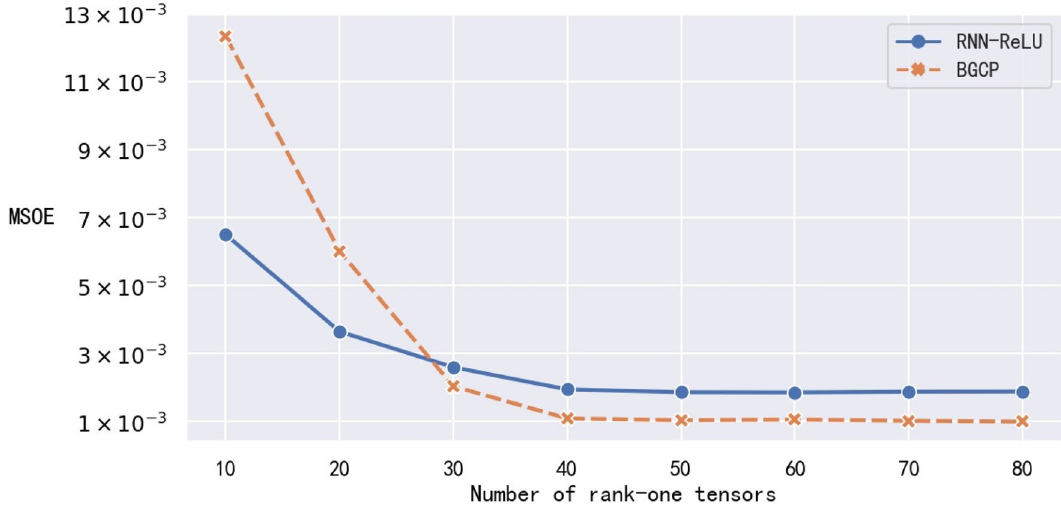
Fig. 9 Relationship between the number of single rank tensors R and mean square error